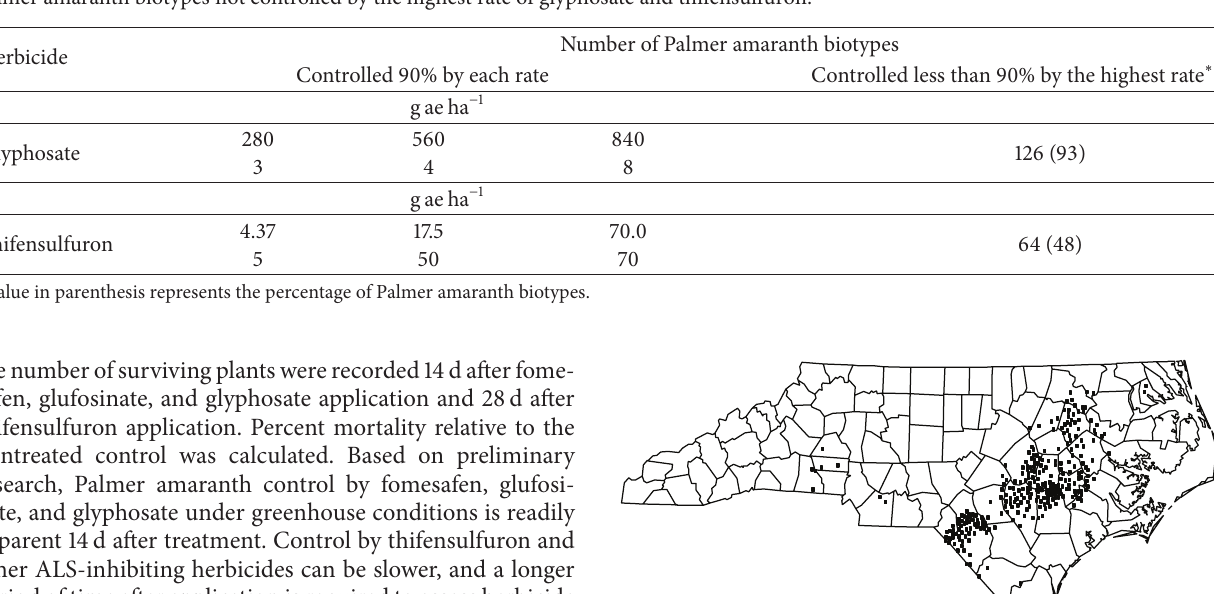
Table 1: Number of Palmer amaranth biotypes controlled at least 90% by glyphosate and thifensulfuron and the number and percentage of